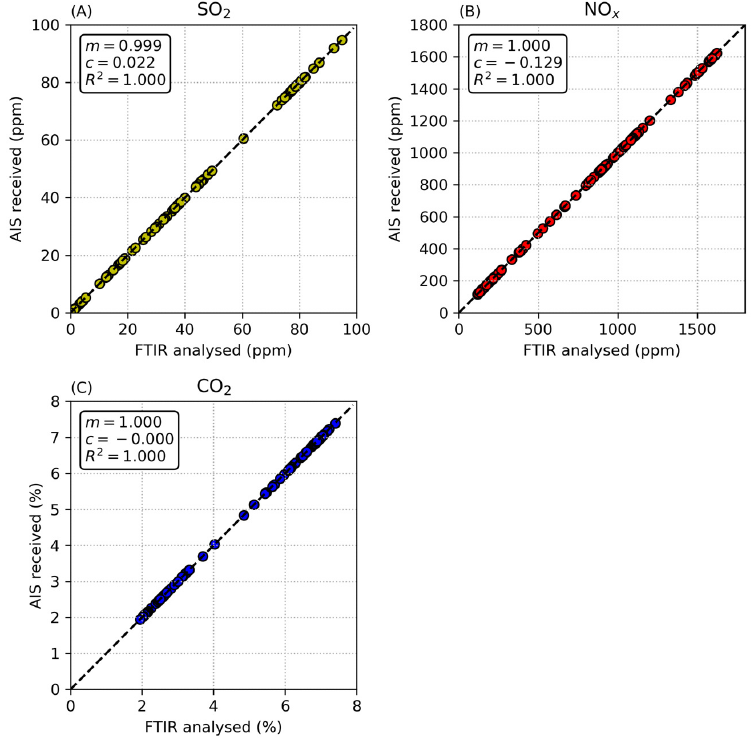
Figure 5. Intercomparison between the time-matched FTIR (Gasmet) analysed gas concentrations and those received via (terrestrial) AIS for ( A ) SO 2 , ( B ) NO x , and ( C ) CO 2 . For each plot, the linear regression and correlation statistics are shown.